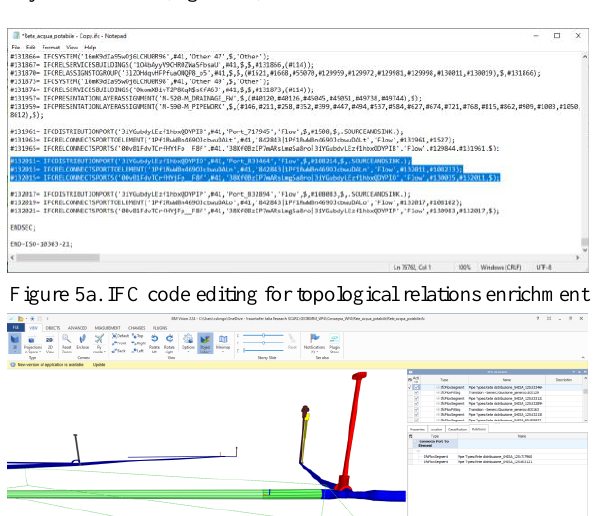
Figure 5b. Result of topological enrichment and visualization of relations among elements in a BIM viewer.